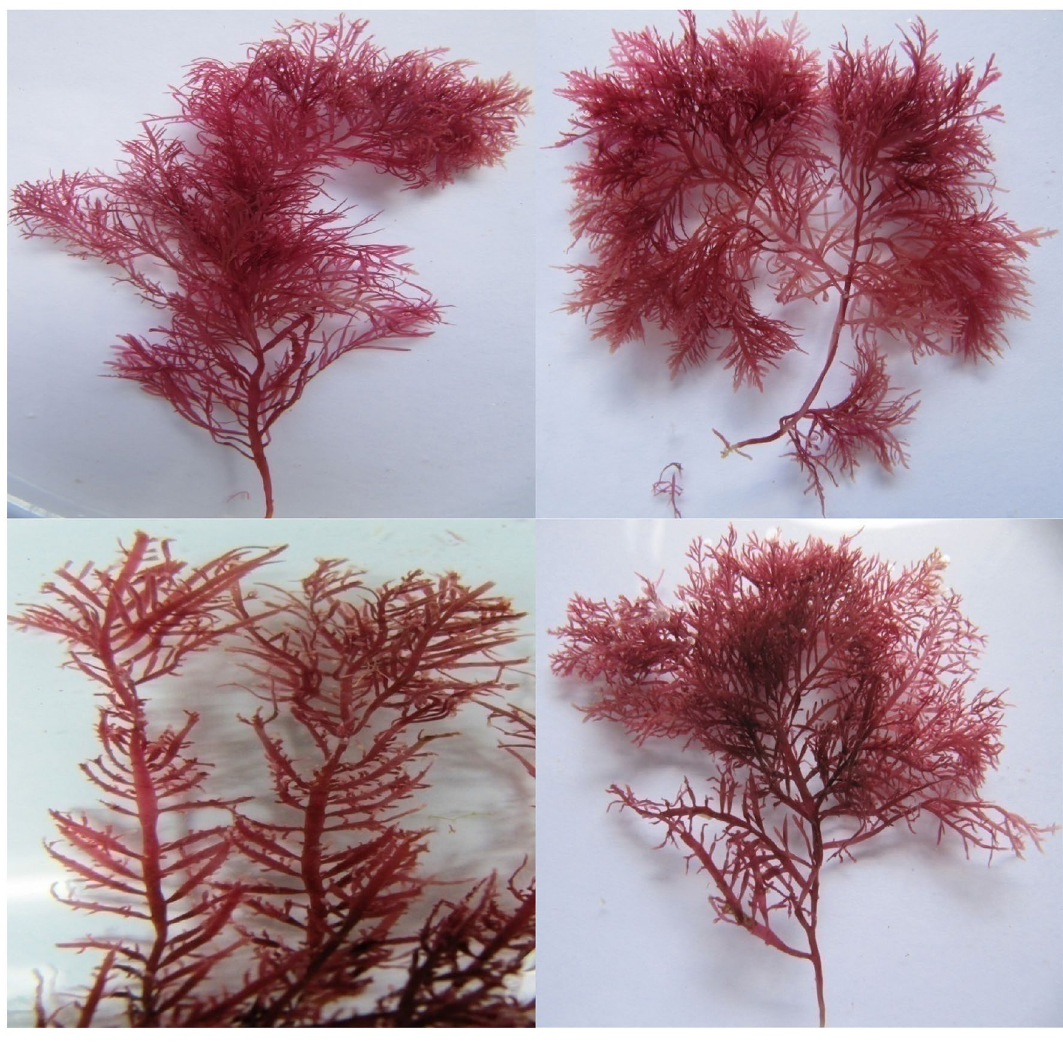
Figure 1. Gelidium corneum